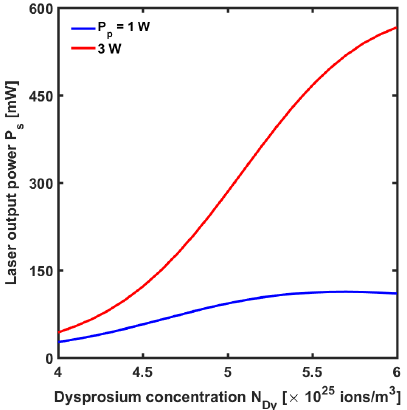
Figure 9. Characteristics of the dysprosium doped chalcogenide fiber laser based on the master oscillator power amplifier (MOPA) configuration. Figure adapted from [34].